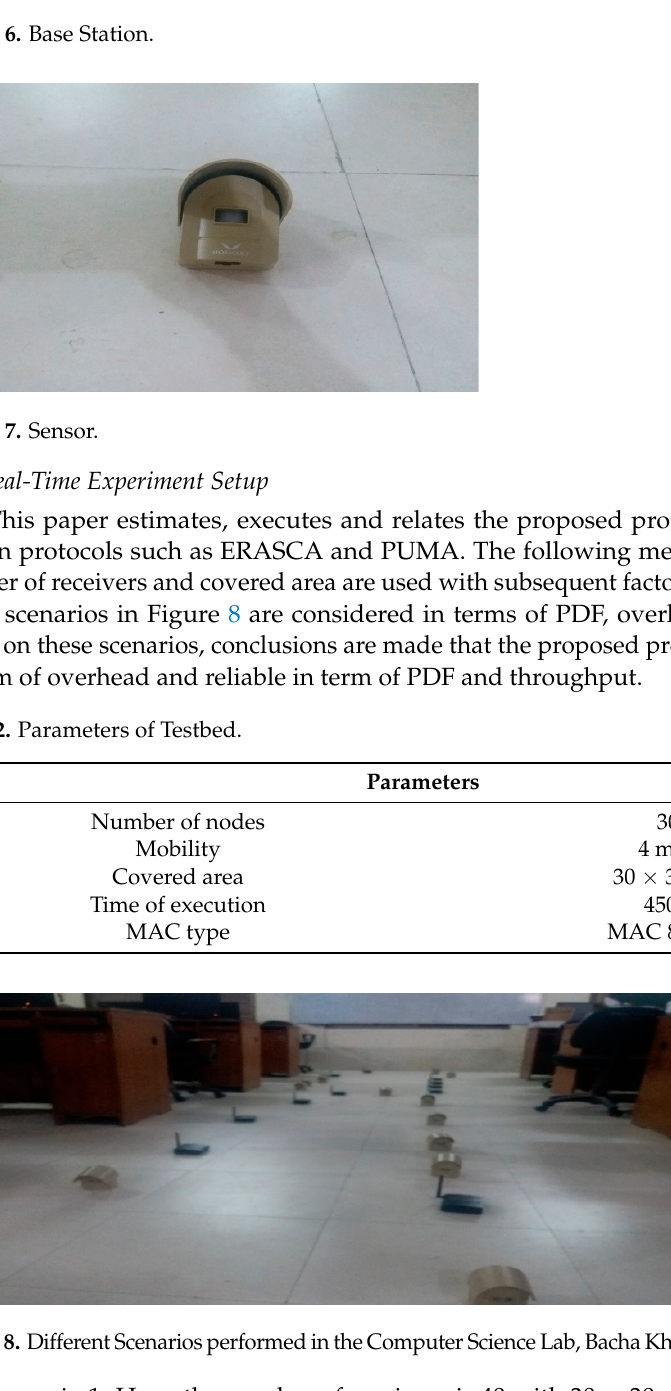
Figure 6. Base Station.